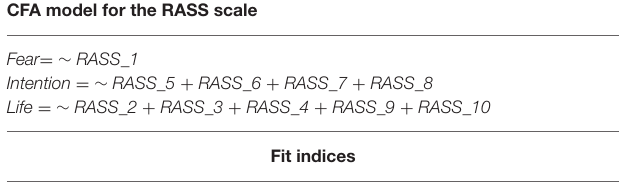
TABLE 1 | Confirmatory factor analysis (CFA) for the first 10 items of the RASS scale based on the three factors originally identified (fear, intention, and life) and the newly developed scales for belief in conspiracy theories (7 items) and Internet use (3 items). CFA model for the RASS